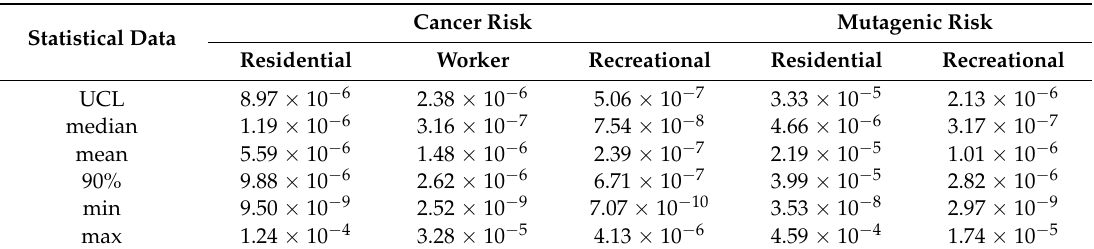
Table 5. Statistical data, including the upper confidence level (UCL) of the mean, of total cancer and mutagenic risks for different land uses of Lisbon